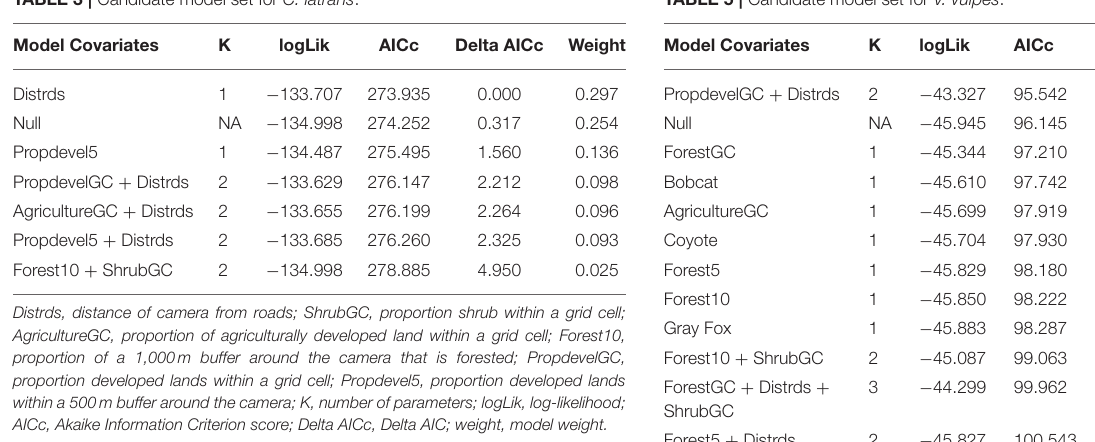
TABLE 5 | Candidate model set for V. vulpes